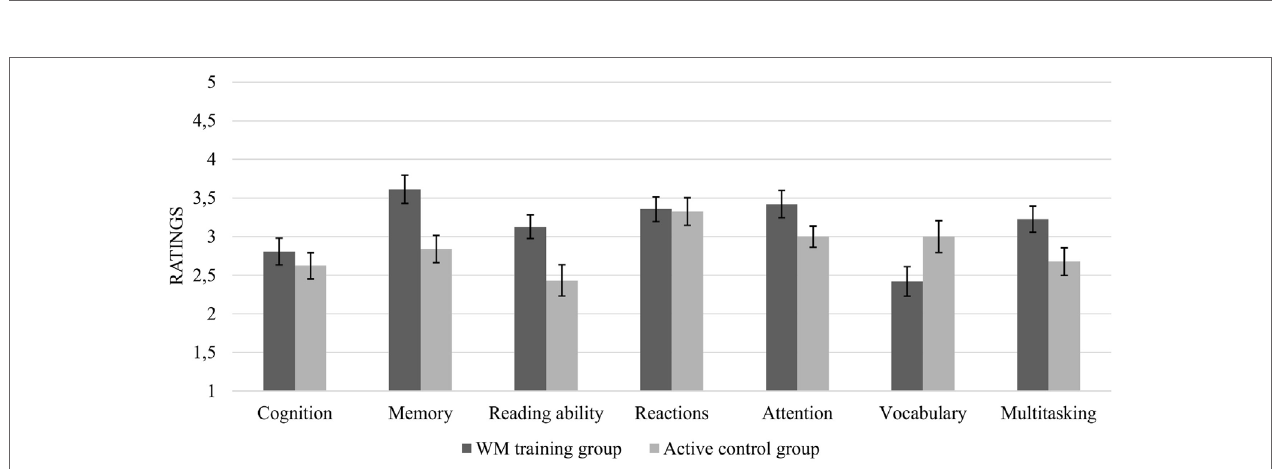
FigUre 6 | Perceived general cognitive improvements at posttest in the WM training group and the active control group. Error bars represent SEMs. WM, working memory.